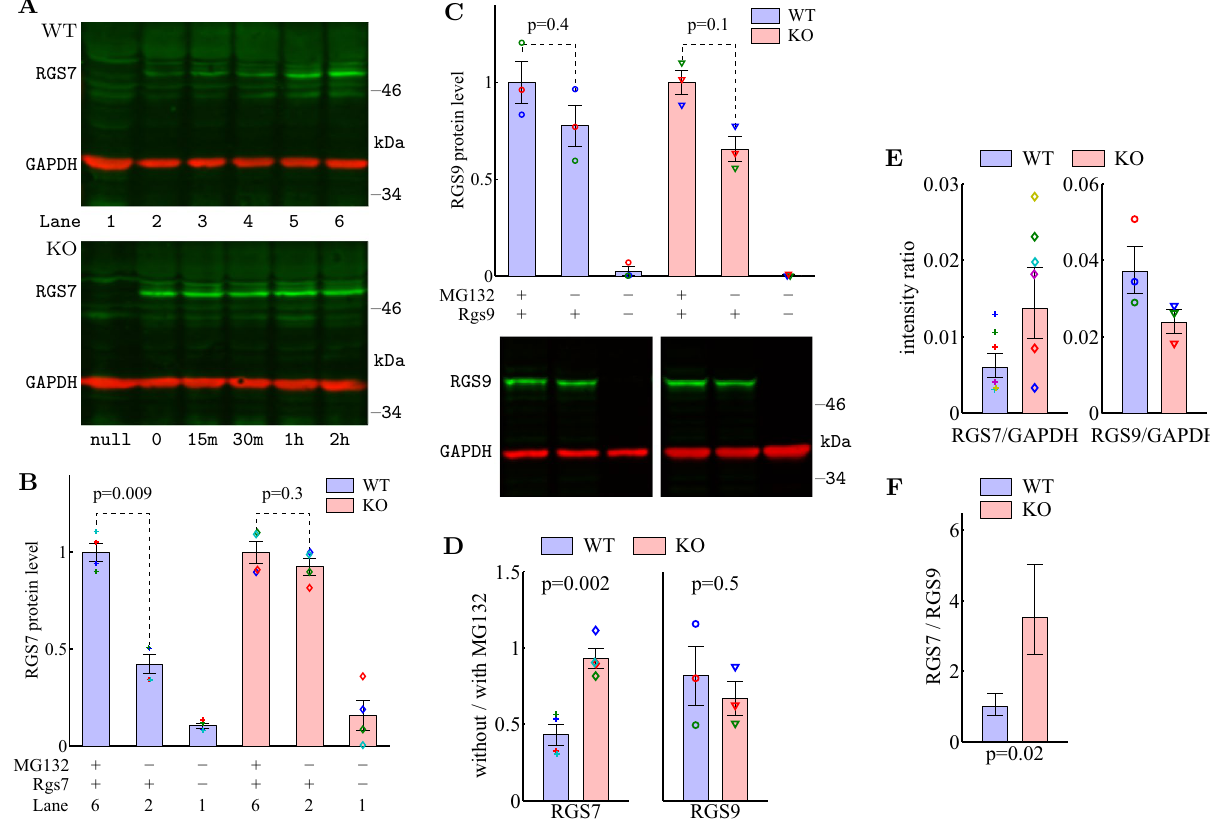
Figure 7. RGS7 is degraded by the proteasome in Ate1-dependent manner. ( A ) Western blot of RGS7 exogenously expressed in wild type (WT) and Ate1 knockout (KO) mouse embryonic fibroblasts transfected with Rgs7. 12 hours after transfection (lane 2), cells were further incubated with the proteasome inhibitor MG132 and were harvested at the indicated time points (lane 3 to 6). RGS7 protein level increases over time only in WT in the presence of MG132. Lane 1 in each panel shows the blot of untransfected control cells. ( B ) Western blot quantification of RGS7 in cells harvested after 2 hours of incubation with MG132, RGS7 without MG132 incubation, and RGS7 in untransfected control. RGS7 protein level significantly increased with MG132 treatment in WT, but not in KO cells. Data points from 4 independent experiments are plotted with a unique symbol for each experiment. ( C ) Western blot quantification of RGS9 in WT and KO cells from 3 independent experiments. The effect of MG132 treatment on RGS9 protein levels does not depend on the WT or KO background, indicating that its degradation is not affected by Ate1. In all colored panels of ( B and C ), RGS protein levels were first normalized to GAPDH loading control and then normalized for each blot. The error bars represent SEM. The p-values are from paired Student’s t-test. ( D ) The ratio of RGS7 level without/with MG132 was significantly higher in KO than WT cells while the ratio of RGS9 level without/with MG132 in KO and WT cells did not differ significantly. The error bars represent SEM. The p-values are from Welch’s t-test. ( E ) Western blot quantification of the stable RGS levels after 12 hours of transfection with GAPDH as loading control. Data from each experiment are plotted with a unique symbol. The error bars represent SEM. However, these cannot be compared directly due to the unknown factors of transfection efficiencies and GAPDH levels potentially different between WT and KO as well as antibody differences. The meaningful comparison is to compare the ratio of two RGS intensities between KO and WT, such that the factors cancel out—assuming they are constant and multiplicative. The ratios are shown in ( F ). Calculation of each average ratio was performed in log2 unit (see "Methods") and plotted in linear fashion, normalized to WT. The error bars represent STD. The p-values are from Welch’s